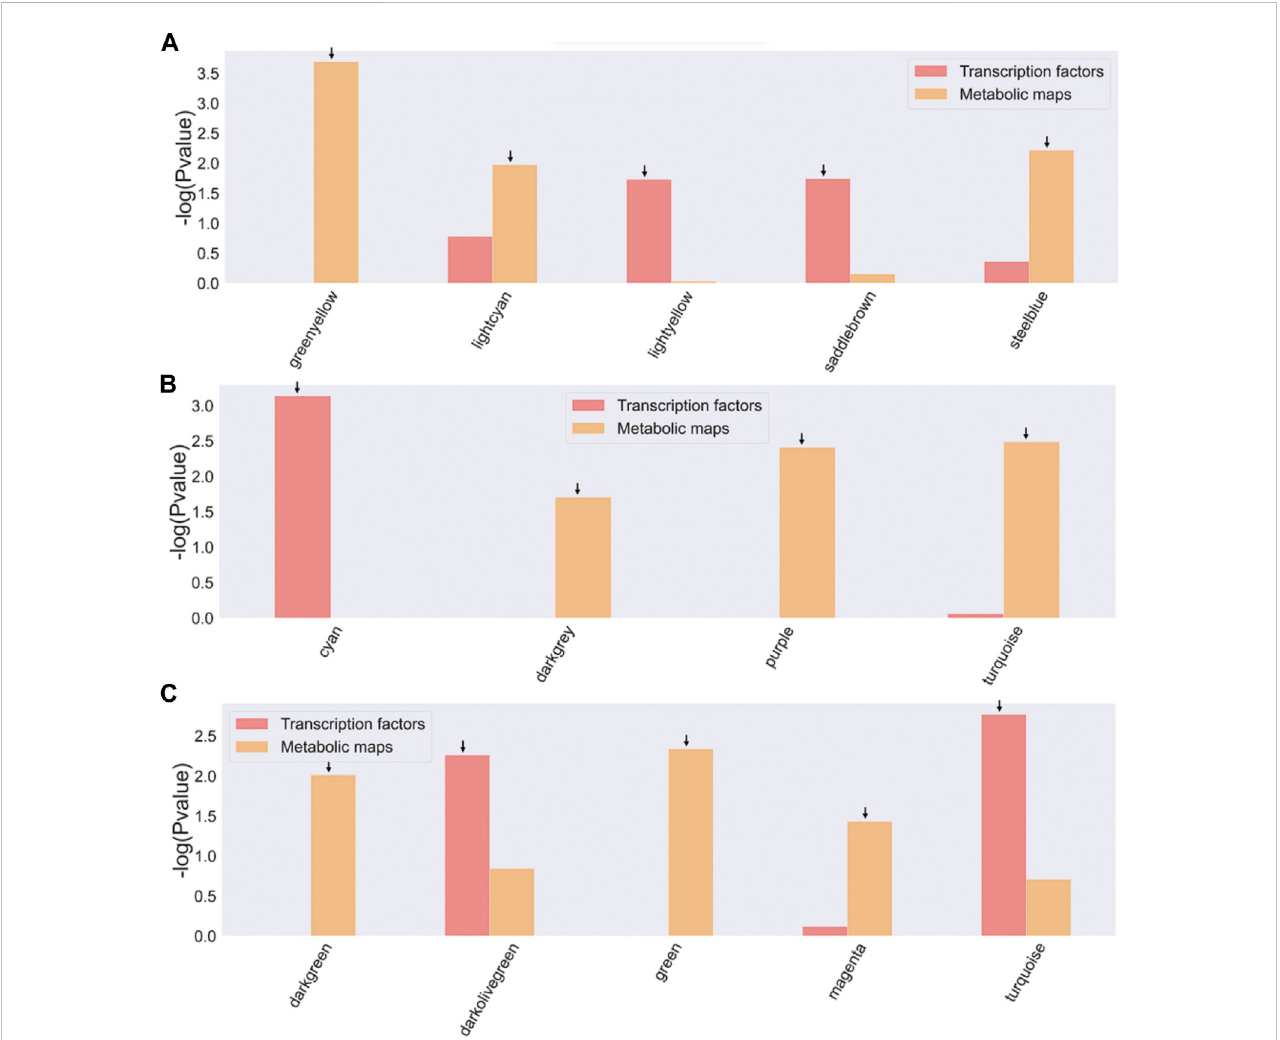
FIGURE 4 Enrichment of TFs and metabolic maps for Bi fi dobacterium strains. (A) B. longum subsp. Infantis ATCC 15697, B bi fi dum SC555, (C) B. longum subsp. Longum SC596. Modules with a − log10 ( p -value) > 1.5 (corresponding to a p -value < 0.05) were selected as enriched and are indicated by an arrow on the bar. The red bars represent modules enriched with TF families, and the orange bars represent modules enriched with metabolic